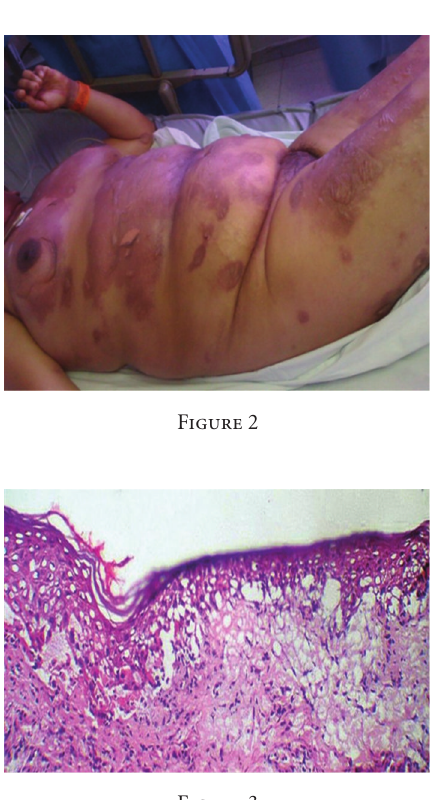
patients with TEN by evaluating 7 independent risk factors (age, presence of malignancy, body surface area involved, serum urea nitrogen level, glucose level, bicarbonate level and heart rate) [7]. The main factors associated with TEN mortality are the occurrence of sepsis at the time of hospitalization (odds ratio [OR] 3.04), age (OR 1.11 per year of age), and total body surface area involved (OR 1.03 per percent of body surface area involved)